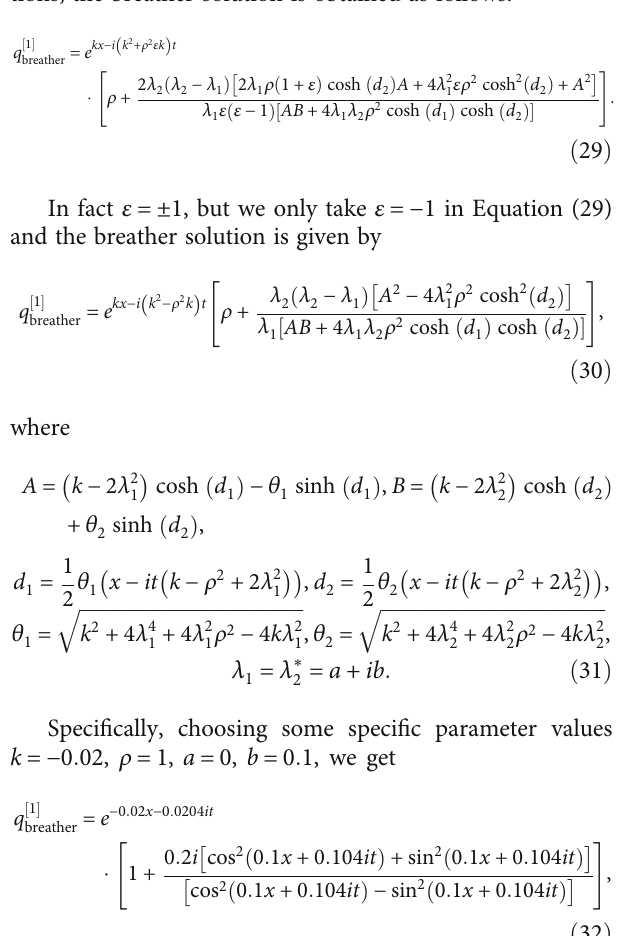
∣ with parameter selections: k = 0 : 05, ρ = 0 : 001, a = 1, b = 0 : 01 . (a) ∣ q ½ 1 (cid:2) rogue